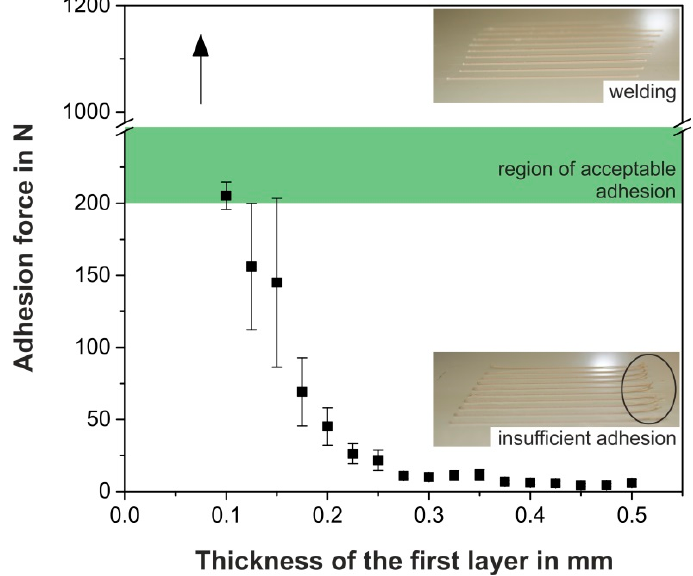
Figure 2. The adhesion force between the printed polypropylene (PP)-composite and the PP heterophasic copolymer (hPP) build platform as a function of the thickness of the first layer measured at room temperature. The arrow in the top left corresponds to overshot forces due to welding. In the top right, the undesired welding of the two materials at thicknesses of the first layer below 0.1 mm is represented. The region of acceptable adhesion according to Ref. [21] is marked in green. In the bottom right, the warping of the strands, as highlighted by the circle, due to insufficient adhesion is illustrated for thicknesses of the first layer that are higher than 0.2 mm.